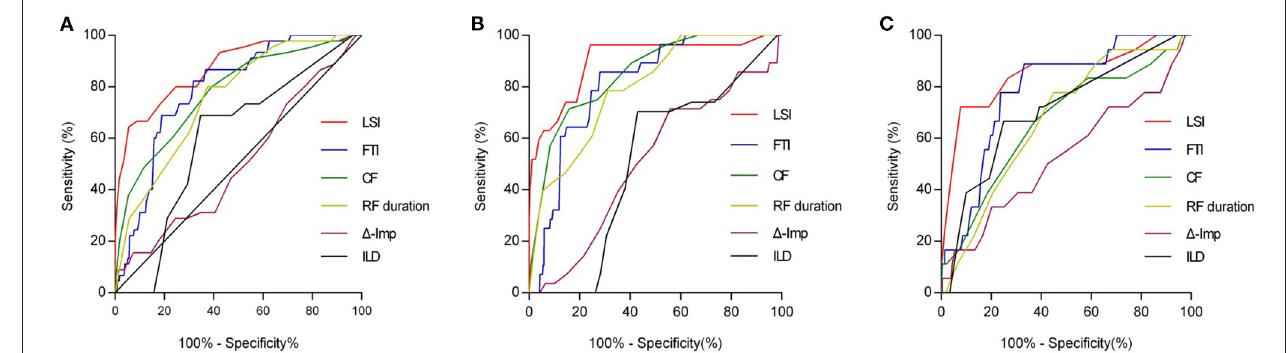
FIGURE 2 | ROC curve analysis for predicting acute conduction gap formation. (A) LSI showed the best predictive value with the AUC curve of 0.87 for all PVs segments. AUC values for FTI, CF, RF duration, 1 -Imp, and ILD were 0.79, 0.78, 0.75, 0.51, and 0.60, respectively. The optimal LSI threshold for predicting gap for all PVs segments was 4.35 (sensitivity 80.0%; specificity 75.4%, p < 0.0001). (B) For anterior wall of PVs, LSI showed the best predictive value with the AUC curve of 0.90. AUC values for FTI, CF, RF duration, 1 -Imp, and ILD were 0.81, 0.85, 0.80, 0.51, and 0.51, respectively. The optimal LSI threshold for anterior wall of PVs was 4.55 (sensitivity 96.3%; specificity 75.8%, p < 0.0001). (C) For posterior wall of PVs, LSI also showed the best predictive value with the AUC curve of 0.85. AUC values for FTI, CF, RF duration, 1 -Imp, and ILD were 0.79, 0.67, 0.67, 0.53, and 0.71, respectively. The optimal LSI threshold for posterior wall of PVs was 3.95 (sensitivity 72.2%; specificity 92.3%, p < 0.0001). ROC, receiver operating characteristic; LSI, lesion size index; AUC, area under the curve; PV, pulmonary vein; FTI, force-time integral; CF, contact force; RF, radiofrequency; 1 -Imp, impedance drop; ILD, interlesion